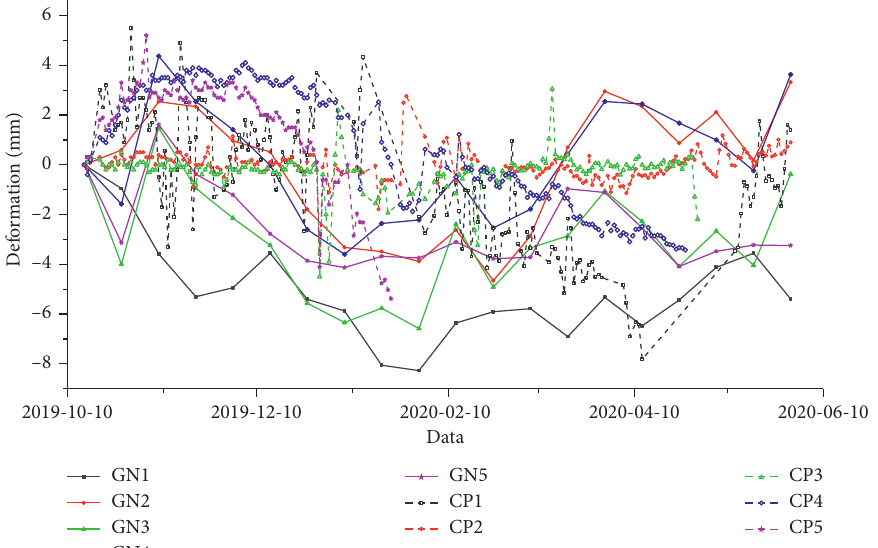
Figure 12: Comparison of the SBAS-InSAR results and the GNSS data.